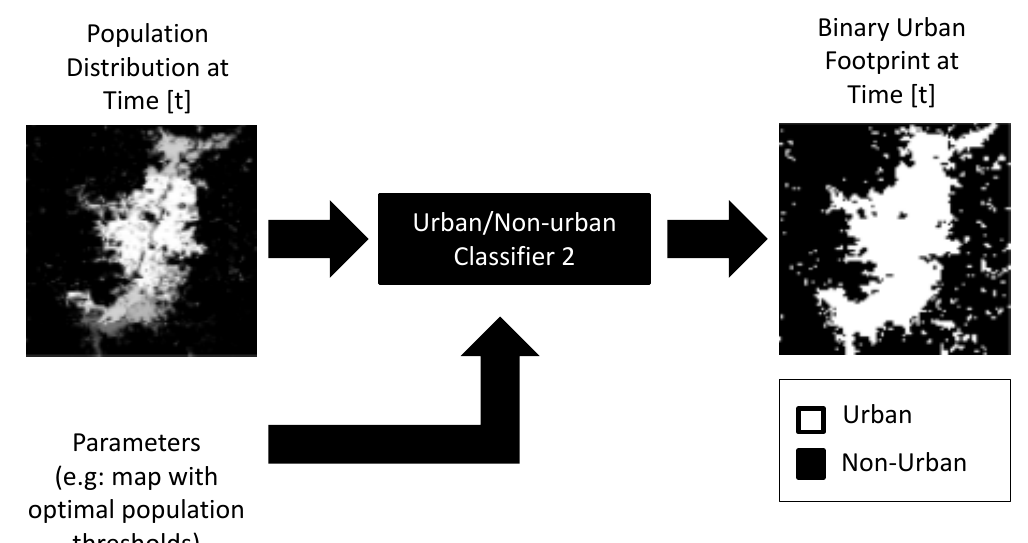
Figure 12. Converting population distribution predictions into estimates of binary urban footprint during